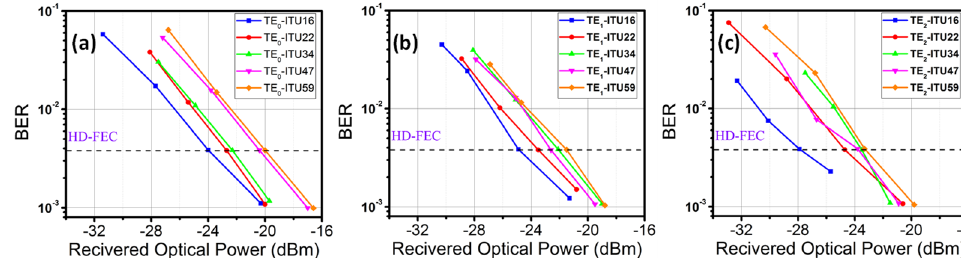
Figure 9. Experimental SNR and bit-loadings for each subcarrier in ( a ) CH1, ( b ) CH2 and ( c ) CH3 at the 1550.12 nm (ITU-34) wavelength channel. Typical constellations of ( d ) 4-QAM, ( e ) 8-QAM, ( f ) 16-QAM, ( g ) 32-QAM.